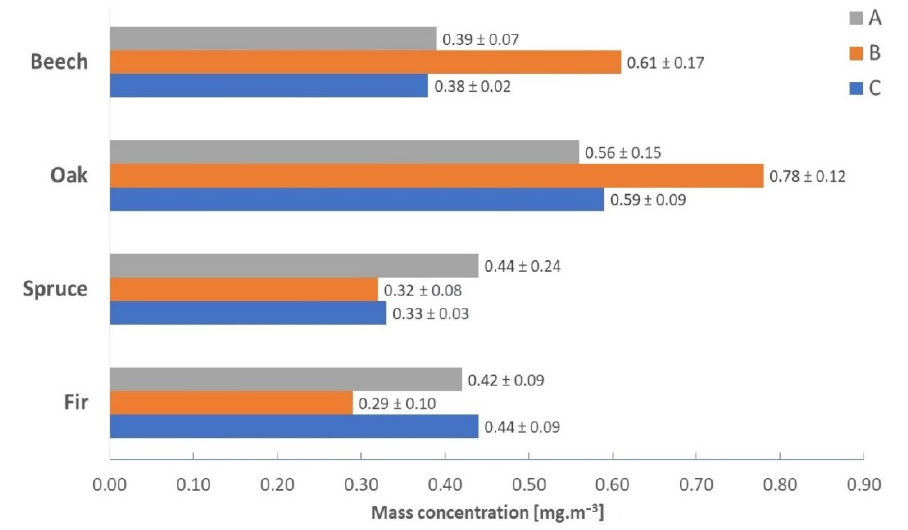
Figure 5. Effect of cutter shape (A—semi chisel, B—full chisel, C—chamfer chisel) and wood species on respirable mass concentration (arithmetic mean ± standard deviation, n = 10).